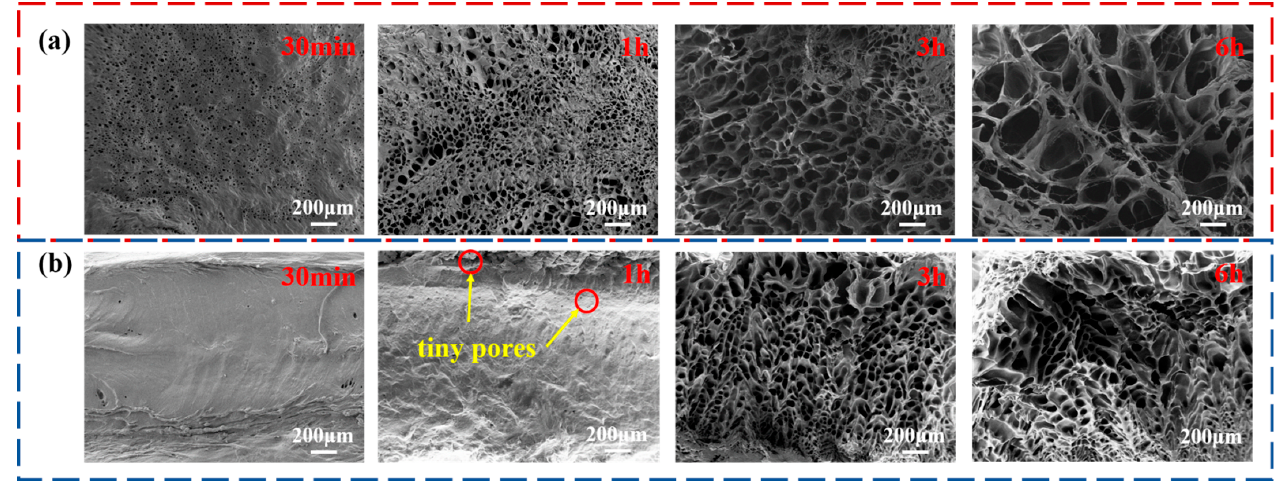
Figure 8. Morphology of PS14-PEG SFDH sample with different swelling time: ( a ) surface, ( b ) fracture.